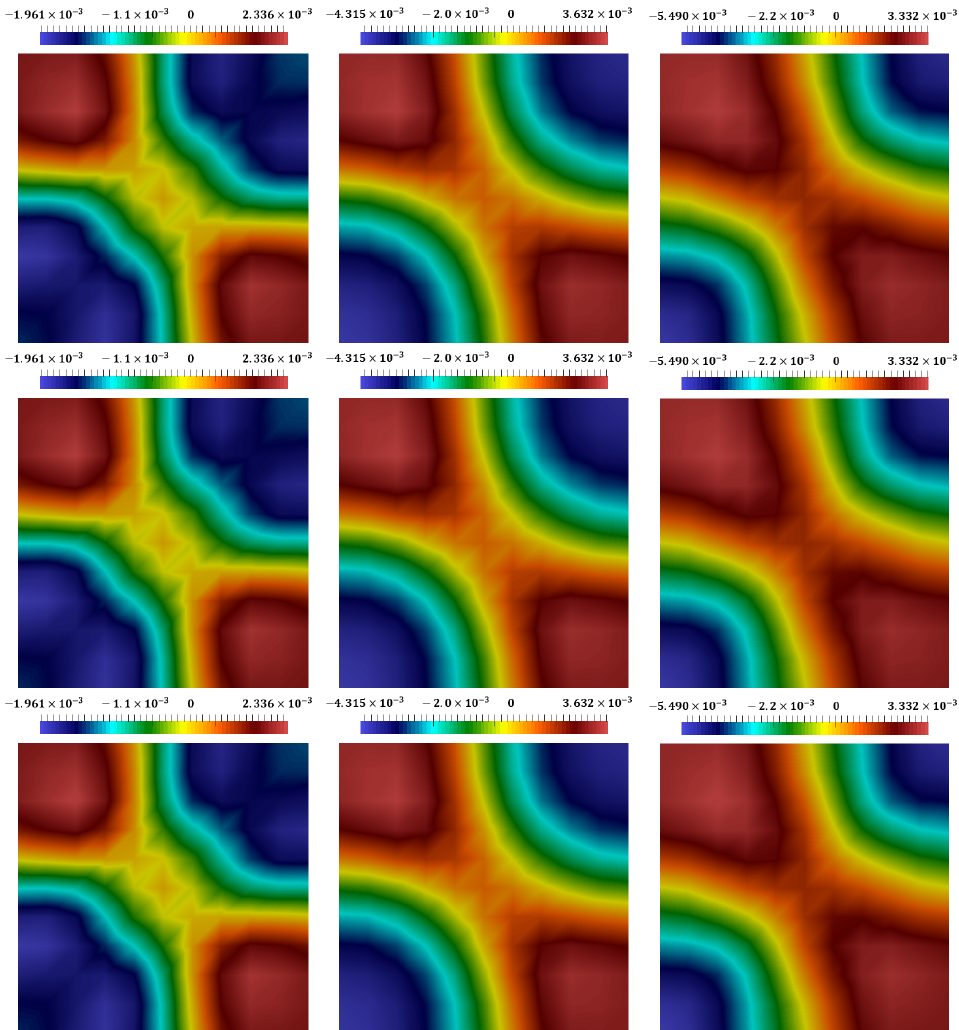
Figure 5. Distribution of pressure for the first continuum at different times, t m with m = 0.4,0.8,1 (from left to right ). ( The first row ): the coupled explicit–implicit solution. ( The second row ): the split explicit–implicit solution. ( The third row ): the proposed approach’s